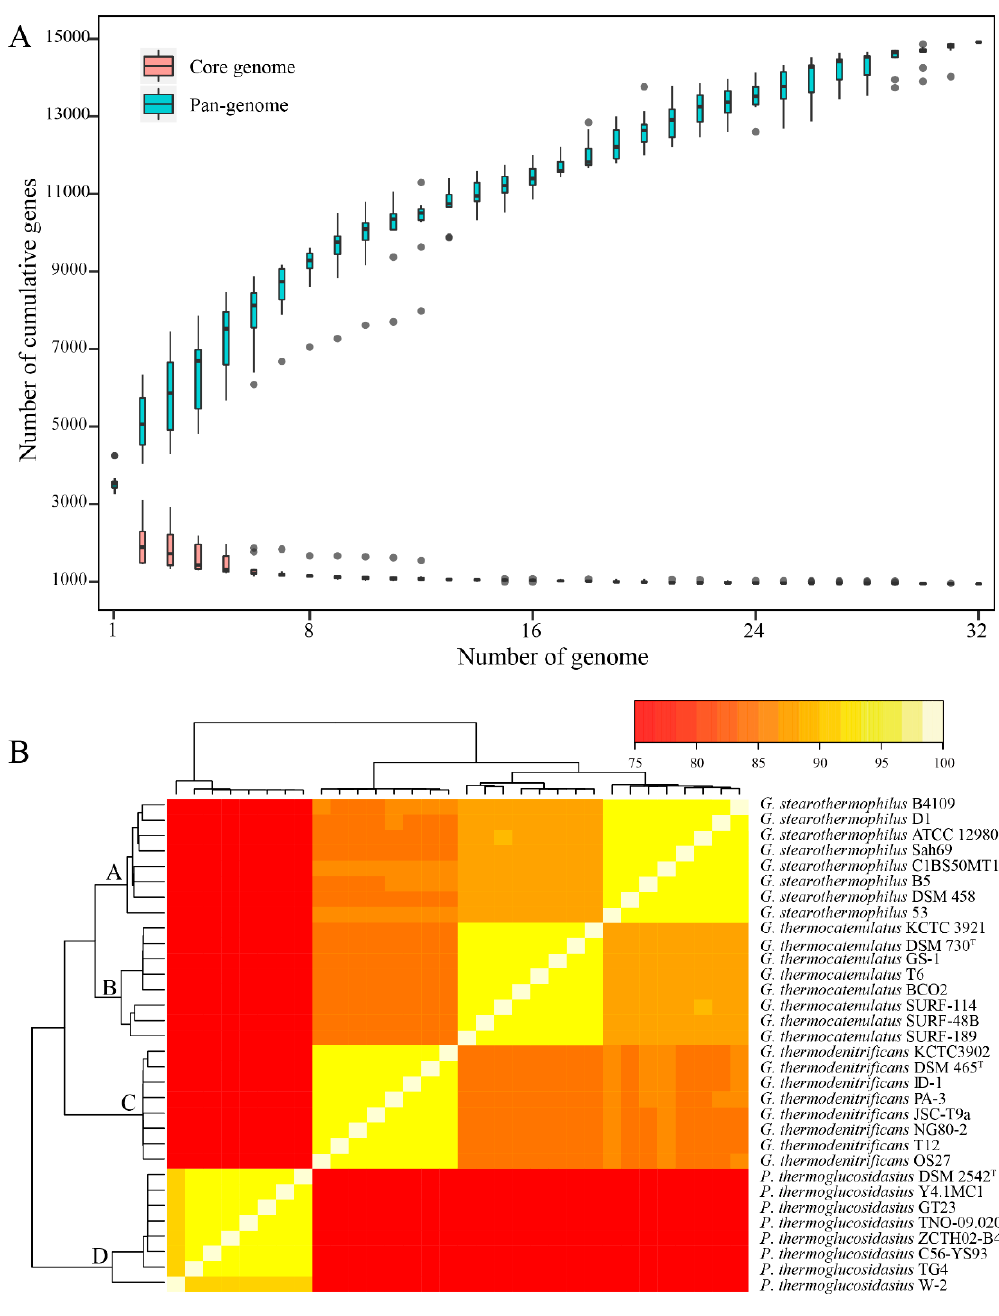
Figure 3. The pan-genome and clustering analysis of Geobacillus strains. ( A ) Development plots of the pan- and core genomes. The boxplots of the pan- (cyan color) and core genomes (pink color) are plotted. ( B ) Clustering of the Geobacillus strains based on the pan-genome ANI matrix. (A) G. stearothermophilus clade, (B) G. thermocatenulatus clade, (C) G. thermodenitrificans clade, and (D) P. thermoglucosidasius clade.